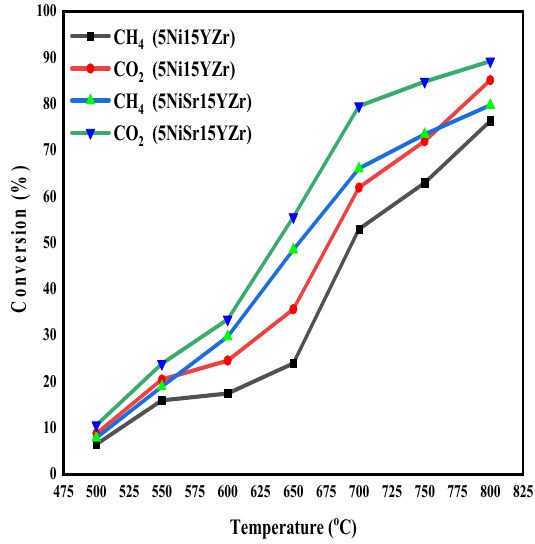
that the 5NiSr15YZr catalyst maintained better performance than the 5Ni15YZr catalyst Figure 12. Conversion versus reaction temperature for 5Ni15YZr and 5NiSr15YZr. for the different flow rates. Figure 12. Conversion versus reaction temperature for 5Ni15YZr and 5NiSr15YZr.